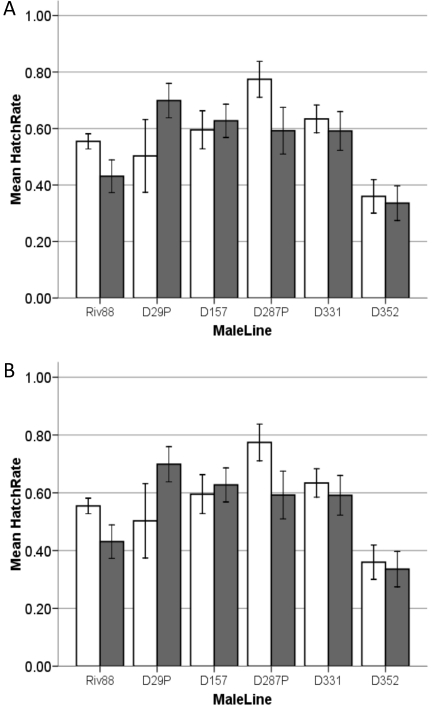
CI induction of old (Riv88) and new (D08) males on new (D08) and old (W88) uninfected females.Females of newly collected lines are shown in white bars, females from W88 are shown in grey. Error bars show ±1 SE of the mean. Bars indicate the mean hatch of uninfected females when mated to infected males who are: A) seven days old, and B) fourteen days old.